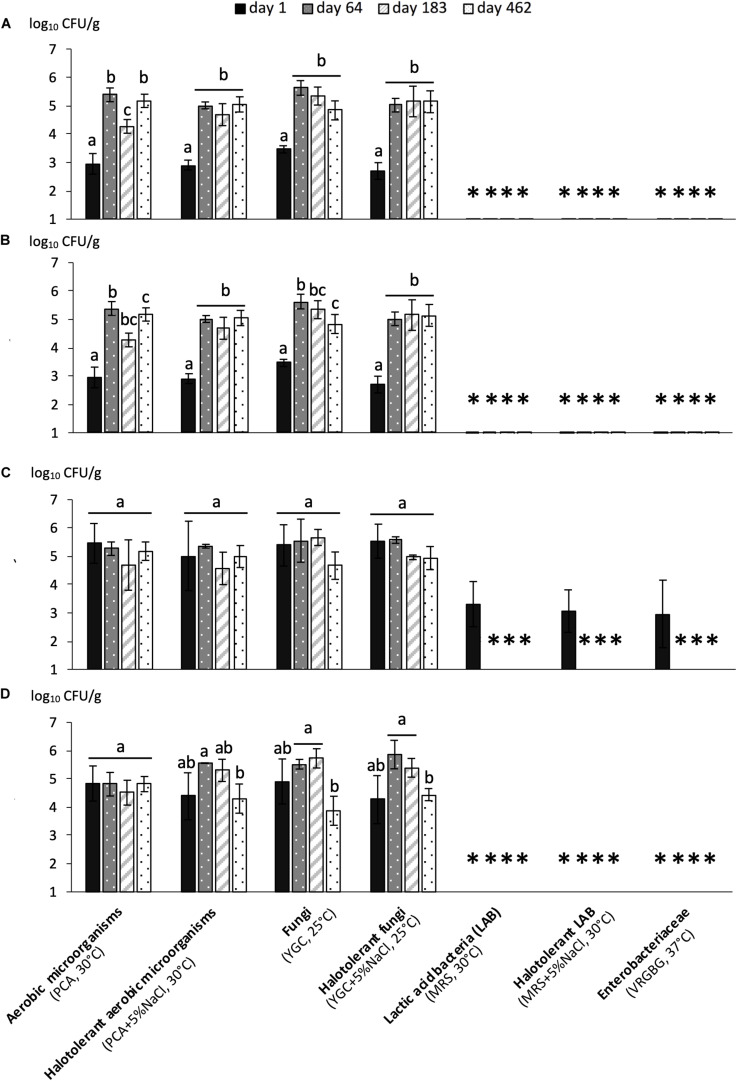
Microbial counts (mean values of 3 replicates ± standard deviation) during fermentation of organically or conventionally grown Nyons olives harvested at early or late stages. (A) R1-Orga: Early harvest-Organic olives, (B) R1-Conv: Early harvest-Conventional olives, (C) R2-Orga: Late harvest-Organic olives and (D) R2-Conv: Late harvest-Conventional olives. Values are expressed as CFU per g of mixed brine and olive (1:1 w/w ratio). For each fermentation, different letters for a given population indicate significantly different counts (P < 0.05) under Tukey’s HSD test. “∗” symbol indicates counts under the detection threshold.